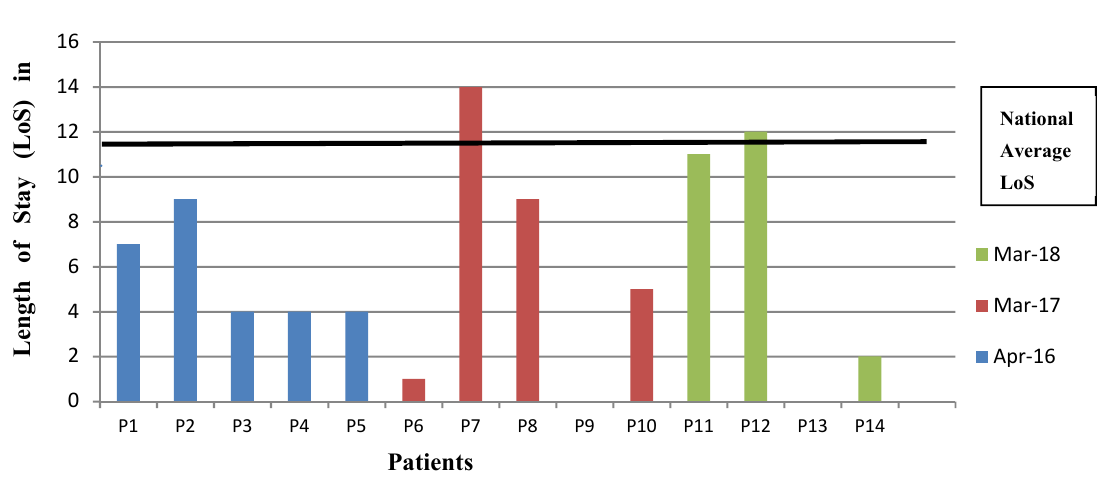
Figure 2. Length of Stay against the National Average.